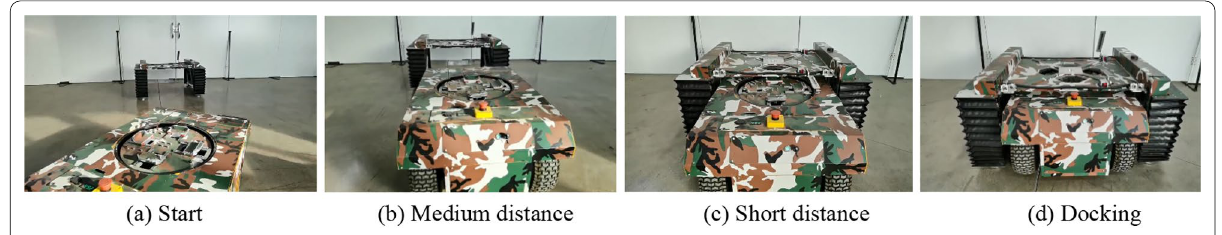
Figure 24 The process of navigation and docking